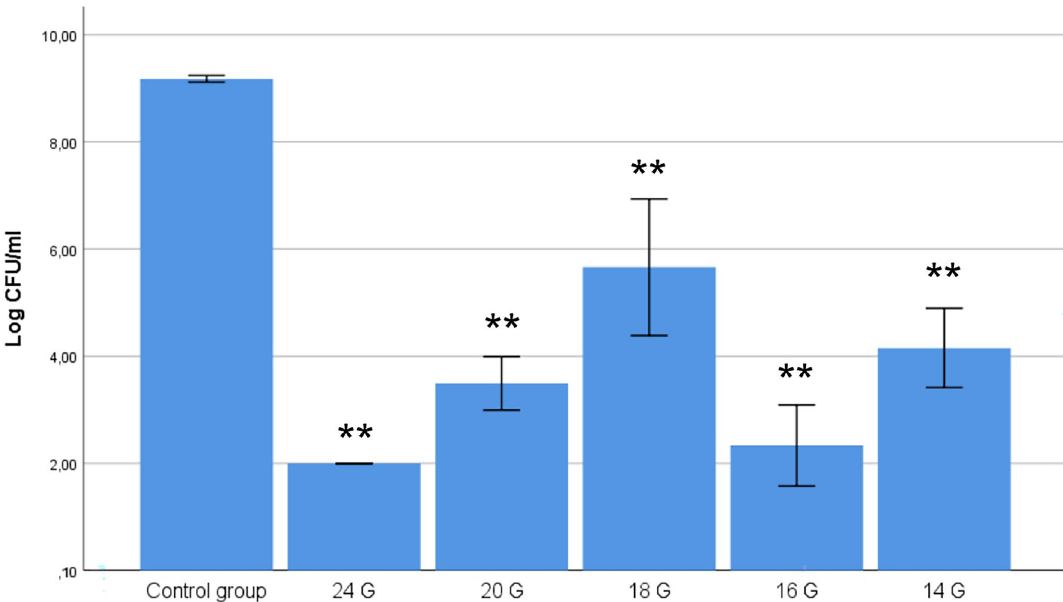
Figure 3. The relevance of needle gauge has an influence on the bactericidal effect of the galvanic currents on S. aureus . Data were expressed as mean with CI of the number of viable log 10 CFU/ml. (**: statistical significance p < 0.001 in relation to the control